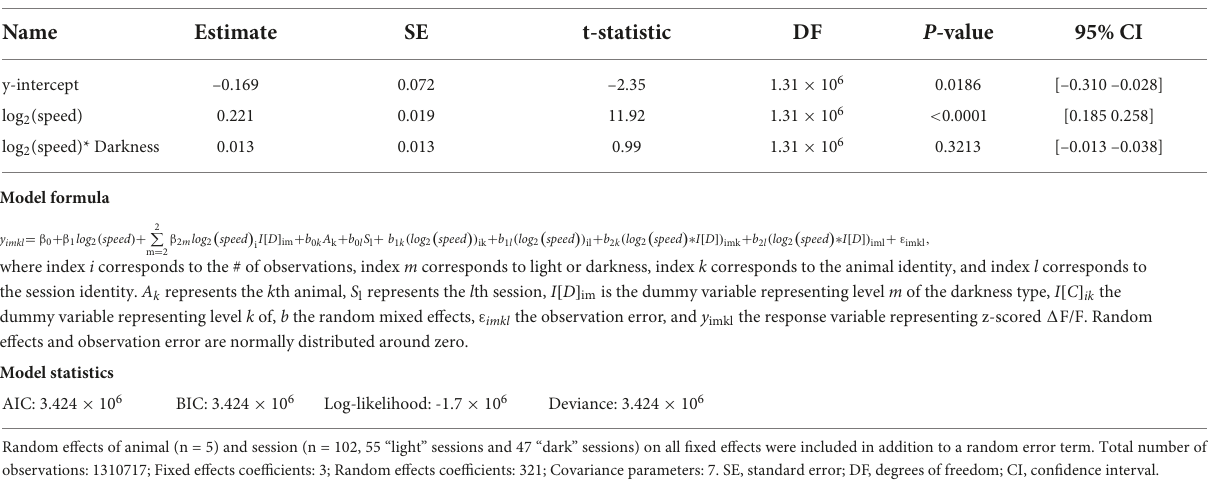
TABLE 2 Results of a linear mixed-effects model of the z-scored (cid:49) F/F of cholinergic activity with three fixed effects, namely the y-intercept, the logarithm of allocentric neck movement speed, and the interaction between the logarithm of allocentric neck movement speed and darkness. Fixed effects